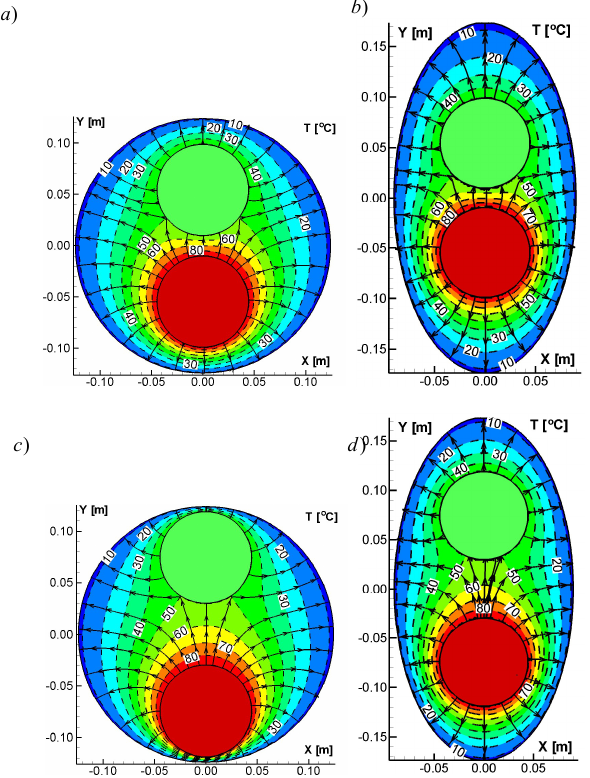
Figure 9. Comparison of temperature fields and heat-lines for circular ( a , c ) and elliptical ( b , d ) thermal insulation for selected distances between the supply and return pipes: s = 0.02 m ( a , b ), s = 0.06 m ( c , d ).